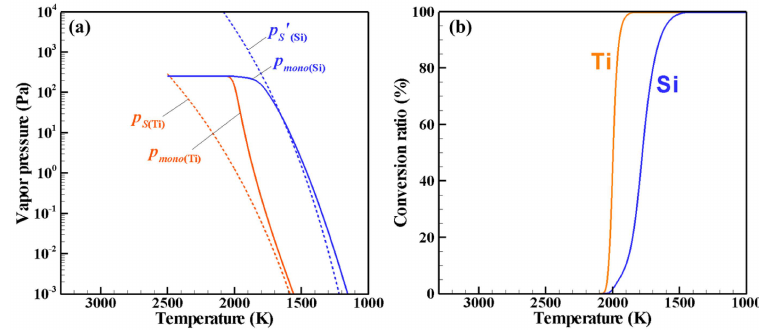
Figure 5. Phase conversion histories for ζ = 10 3 : ( a ) vapor pressures and ( b ) conversion